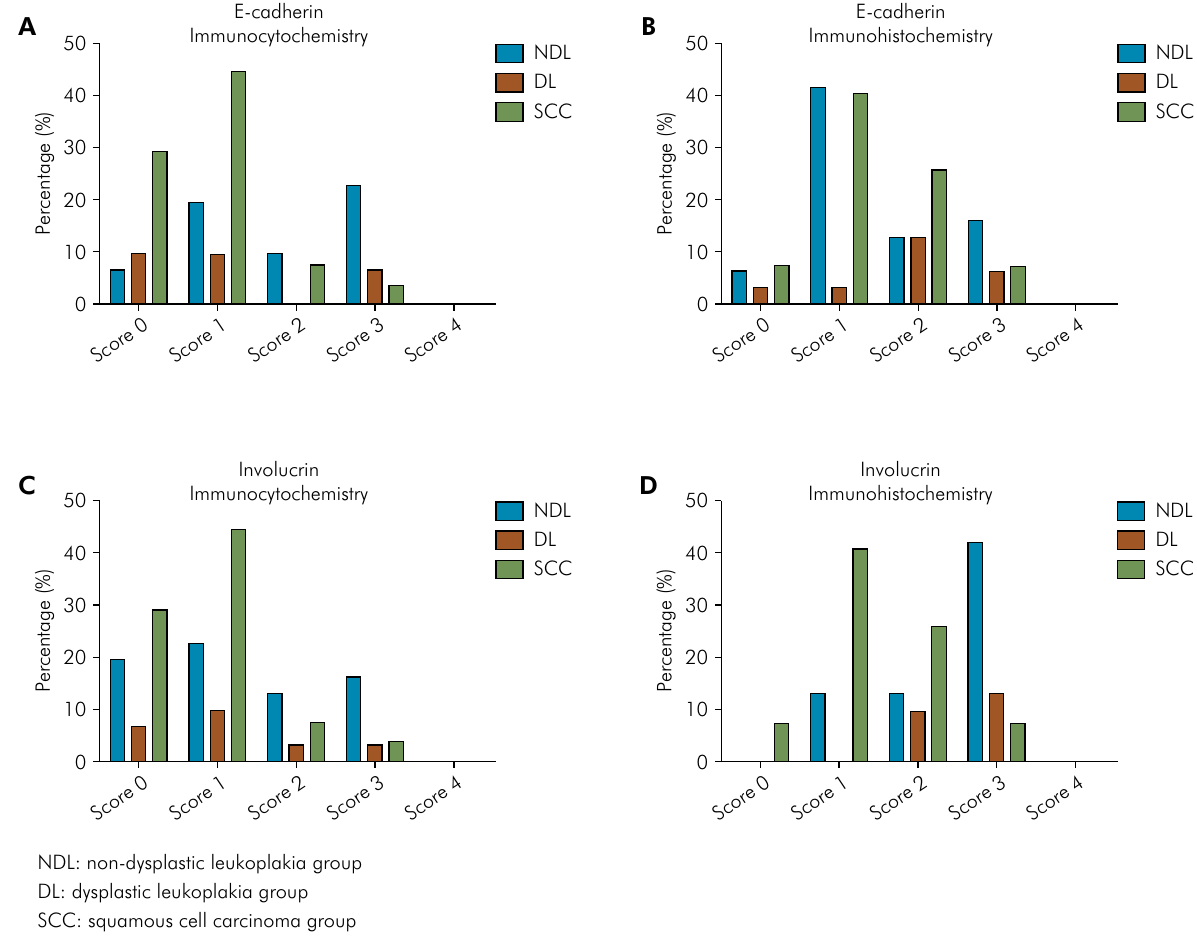
Figure 2. Graphs comparing the scores of the immunocytochemical and immunohistochemical analyses of E-cadherin and involucrin in the leukoplakia and squamous cell carcinoma groups.